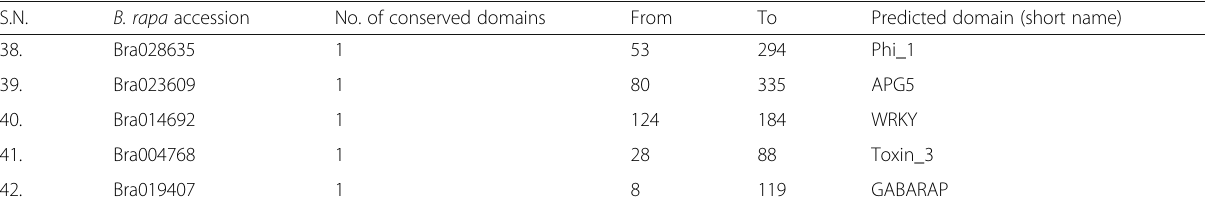
Table 3 Predicted conserved domains in identified up-regulated Brassica rapa sequences with their positions under contrast JAMC (Continued)